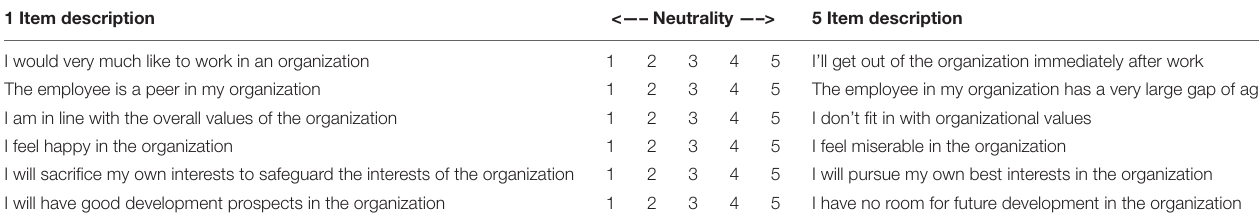
TABLE 1 | Example items from the EOPD scale.